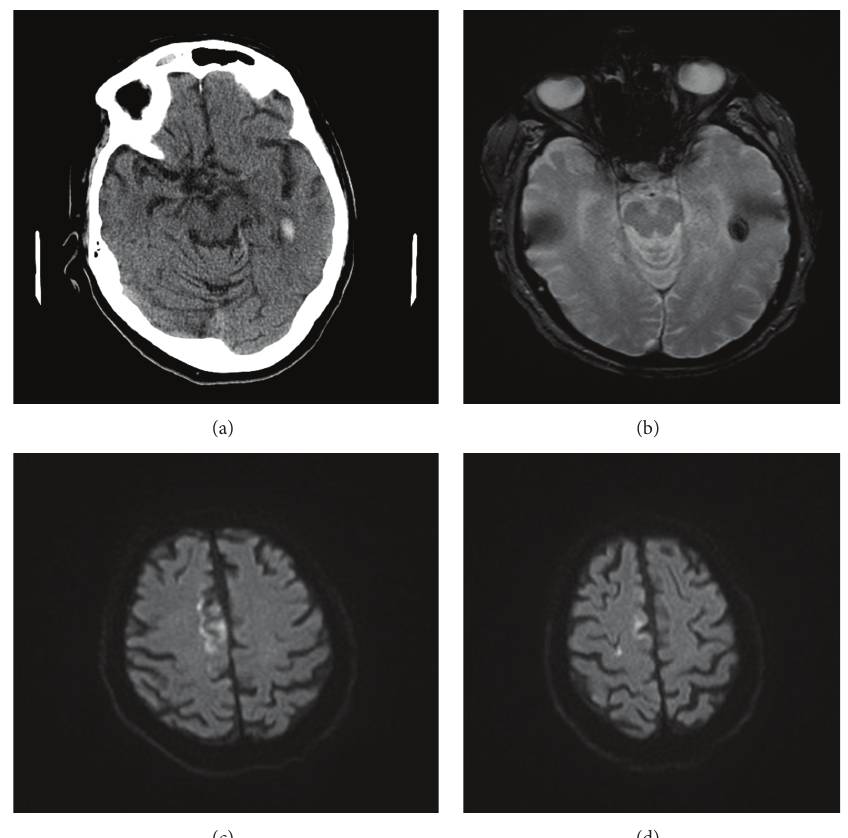
Figure 1: Subject presented with acute left hemiparesis, leg more affected than arm. Routine day one CT (a) and day 5 MRI (b) demonstrate a small haemorrhage in the left temporal lobe, away from the main area of infarction, shown on diffusion weighted MRI (c) and (d), mainly in the territory of the right anterior cerebral artery. No clinical deterioration was